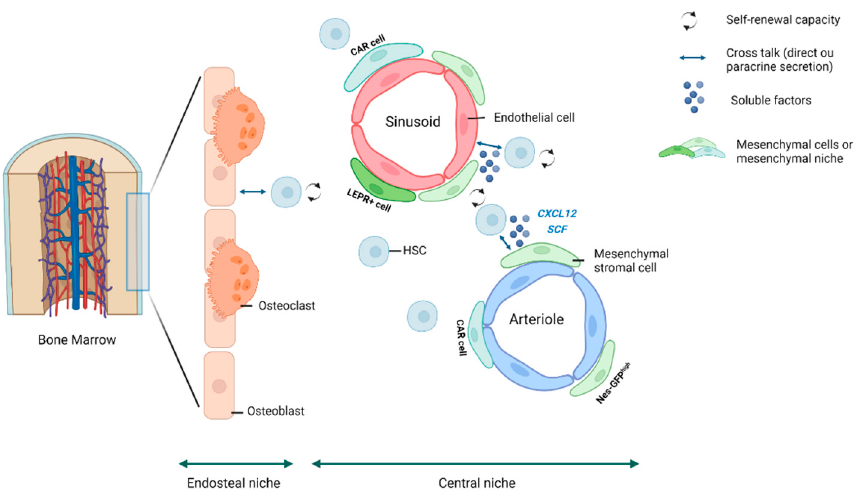
Figure 1. The bone marrow HSC niche. Schematic representation of the hematopoietic stem cell niche, divided into two main compartments: the endosteal niche and the central niche. Both compartments are composed of HSCs surrounded by other cells that regulate their fate. Mesenchymal cells, shown in green, represent one of the main components that regulate HSCs. Because of the heterogeneity of MSCs, we group them under the term “mesenchymal niche”.